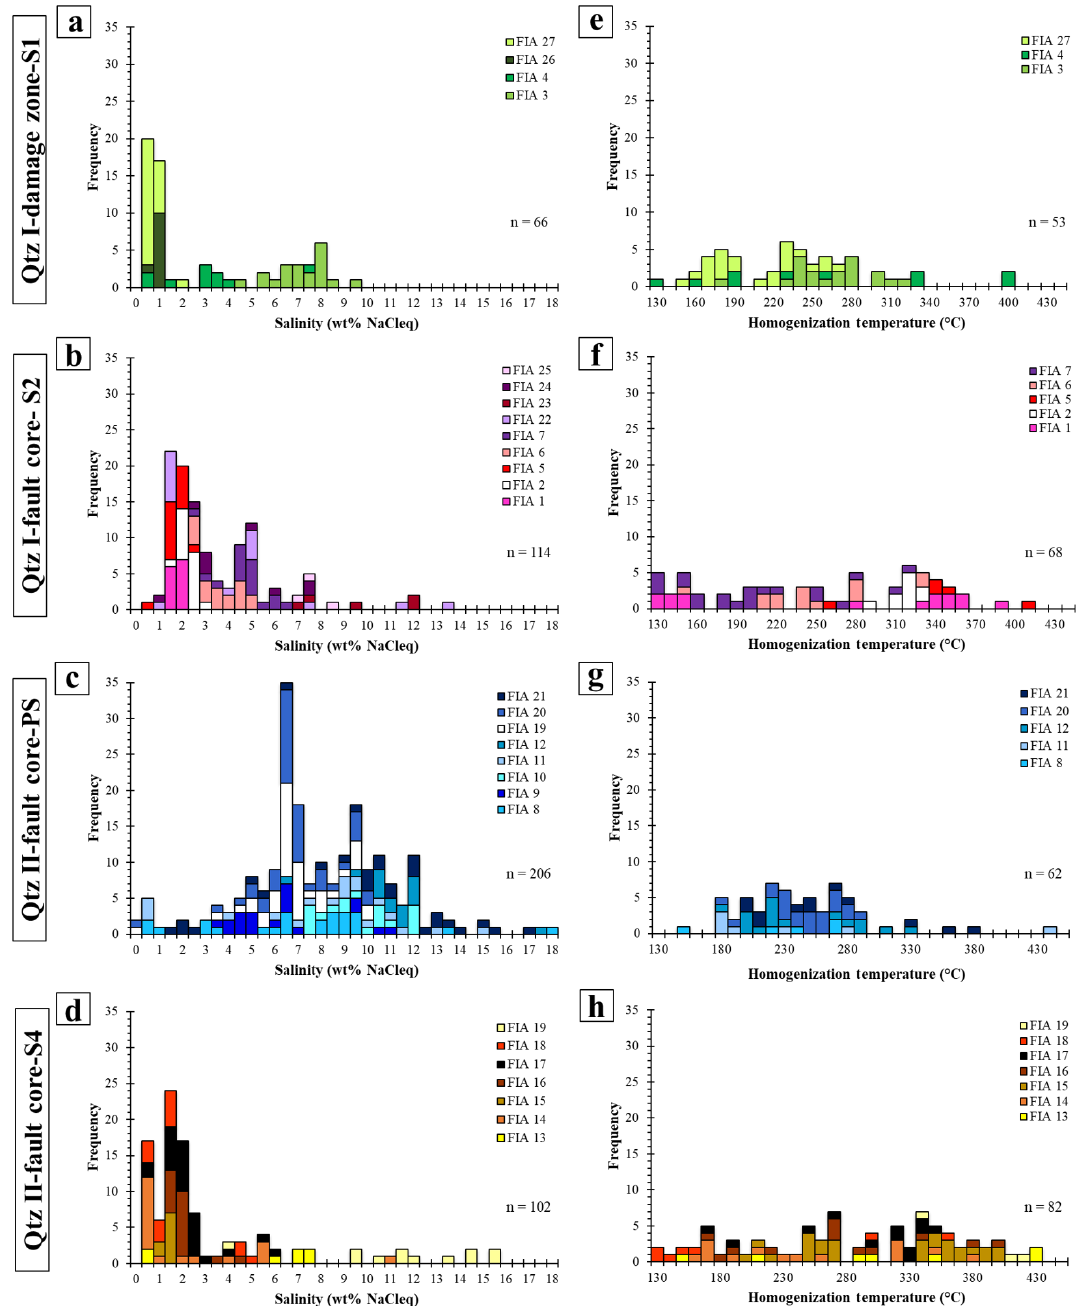
Figure 10. Microthermometric data of the studied FIAs. Panels (a) – (d) show the bulk salinities of individual FIAs calculated from the Tm ice data, while panels (e) – (h) refer to the temperatures of final homogenization in the same assemblages. Notice that the data report the properties of individual FIAs according to their occurrence within Qtz I of the damage zone, Qtz I from the fault core, and Qtz II from the fault core. Notice that pseudosecondary (PS) and secondary (S) FIAs identify progressive later stages of fluid entrapment and can be used to constrain the fluid properties in the fault zone. Notice also that the measured ranges of Th tot spread across T intervals that are too large to represent entrapment at equilibrium (e.g. FIA 7 of Qtz I from fault core: 130–320 ◦ C), which suggests post-entrapment re-equilibration of the inclusions. Fluid bulk composition is expressed as salinity, which is conventionally reported as weight percent of NaCl equivalents (wt% NaCleq; Roedder,